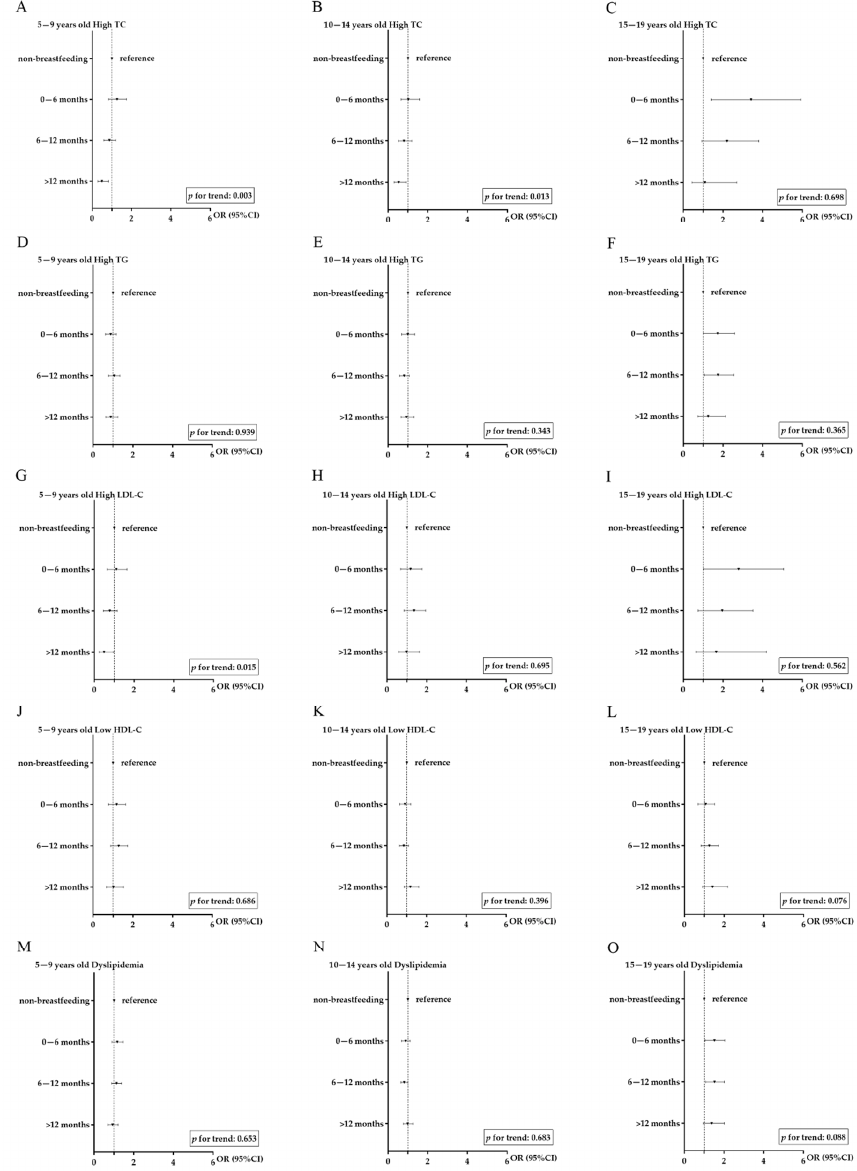
Figure 2. The risk of abnormal lipid among different breastfeeding groups, stratified by age group. ( A ): association between breastfeeding duration and high total cholesterol (TC) in children aged 5–9 years old; ( B ): association between breastfeeding duration and high TC in children aged 10–14 years old; ( C ): association between breastfeeding duration and high TC in children aged 15–19 years old; ( D ): association between breastfeeding duration and high triglyceride (TG) in children aged 5–9 years old; ( E ): association between breastfeeding duration and high TG in children aged 10–14 years old; ( F ): association between breastfeeding duration and high TG in children aged 15–19 years old; ( G ): association between breastfeeding duration and high low-density lipoprotein cholesterol (LDL-C) in children aged 5–9 years old; ( H ): association between breastfeeding duration and high LDL-C in children aged 10–14 years old; ( I ): association between breastfeeding duration and high LDL-C in children aged 15–19 years old; ( J ): association between breastfeeding duration and low high-density lipoprotein cholesterol (HDL-C) in children aged 5–9 years old; ( K ): association between breastfeeding duration and low HDL-C in children aged 10–14 years old; ( L ): association between breastfeeding duration and low HDL-C in children aged 15–19 years old; ( M ): association between breastfeeding duration and dyslipidemia in children aged 5–9 years old; ( N ): association between breastfeeding duration and dyslipidemia in children aged 10–14 years old; ( O ): association between breastfeeding duration and dyslipidemia in children aged 15–19 years old. Notes: adjusted for region, sex, parental education level, children’s BMI, physical activity, sugar-sweetened beverage consumption, meat consumption, and frequency of high-energy food and fried